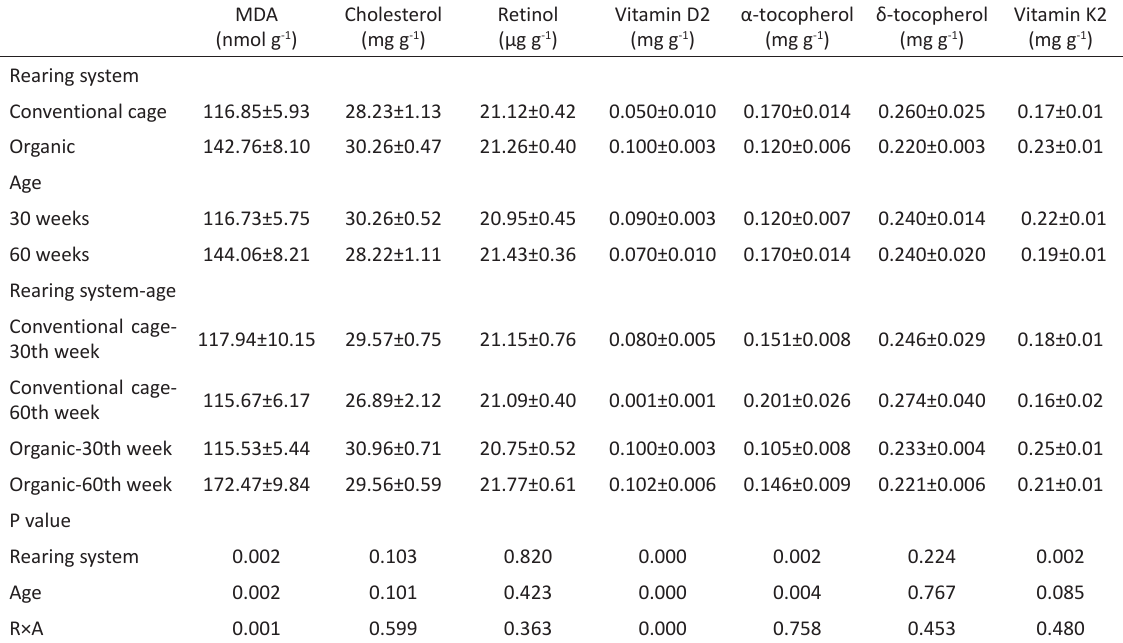
Table 8. Amounts of MDA, cholesterol, and vitamins A (retinol), D (D2), E (α and δ tocopherols), and K (K2) in the egg